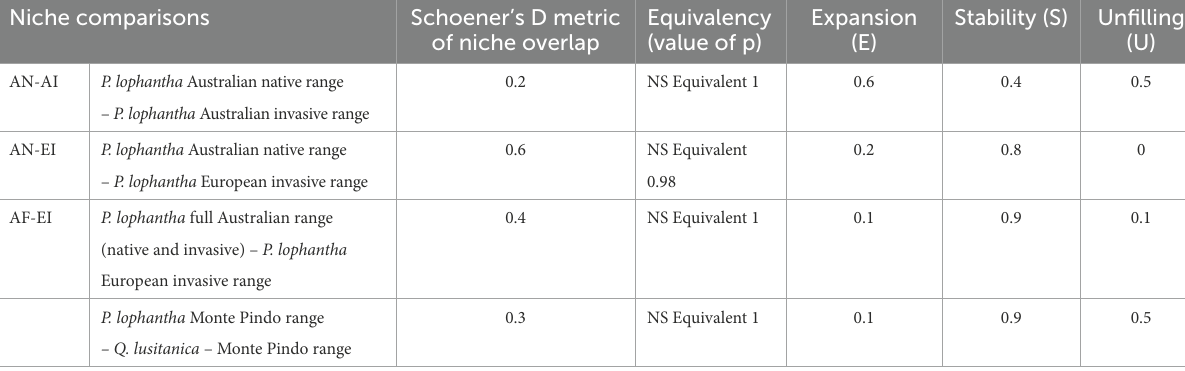
TABLE 1 Results of niche change indices derived from (1) Paraserianthes lophantha large-scale macroclimatic niche comparisons (2) Fine-scale study of niche overlap between P. lophantha and Quercus lusitanica . Niche